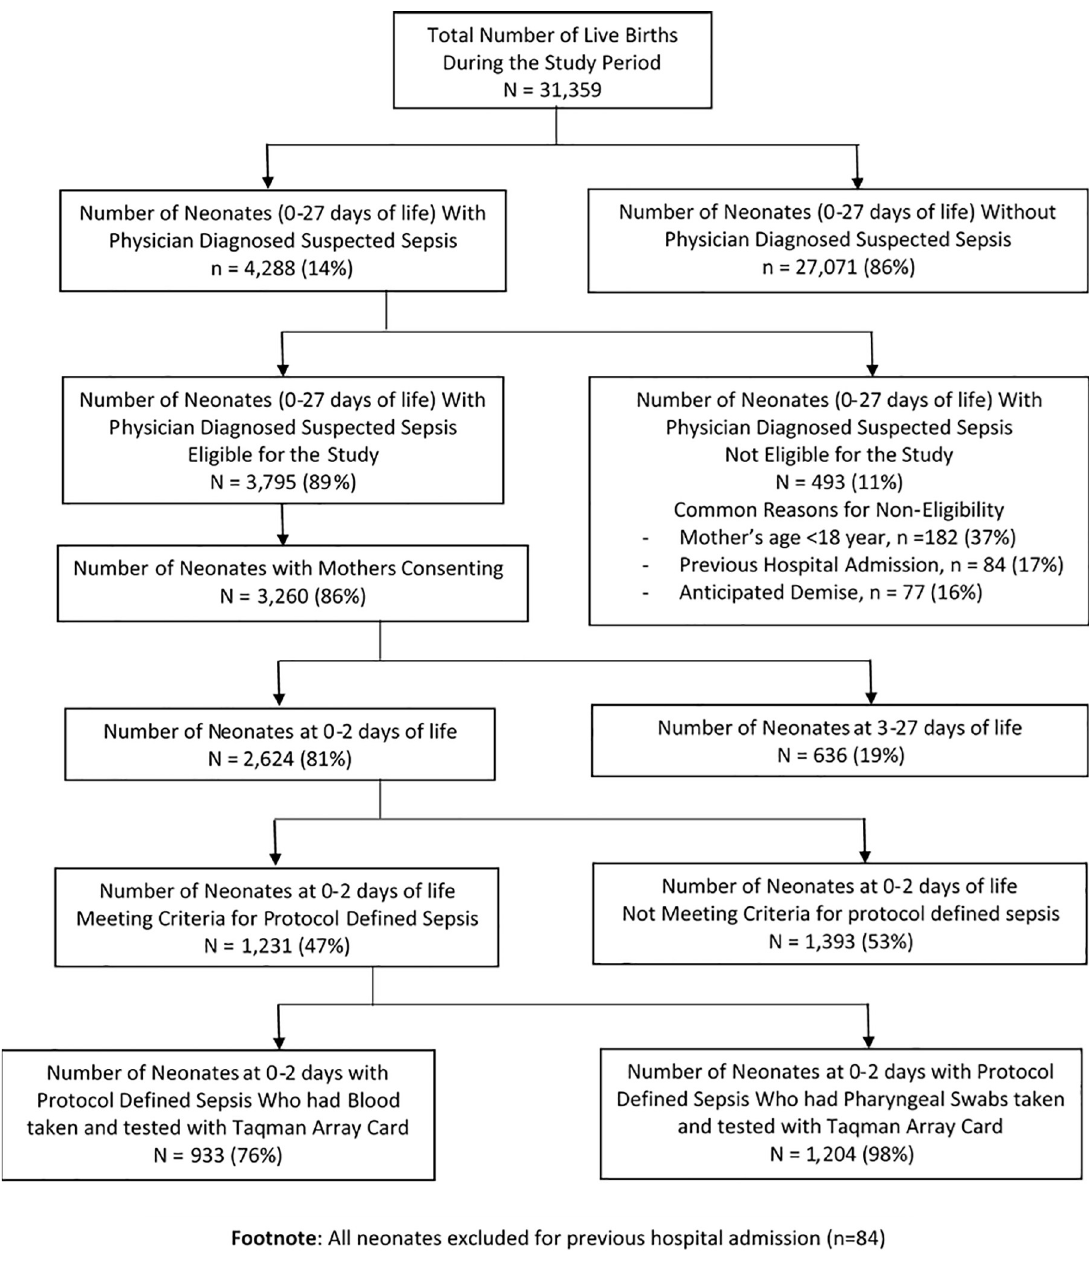
Fig 1. Flow chart of enrolled neonates with physician diagnosed suspected and protocol defined sepsis.